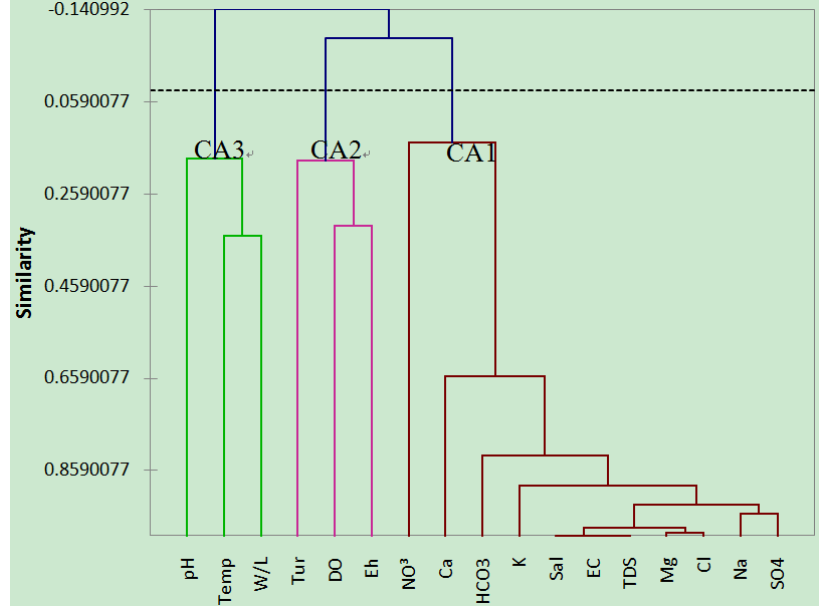
Figure 4. Dendrogram based on the clustering of groundwater quality